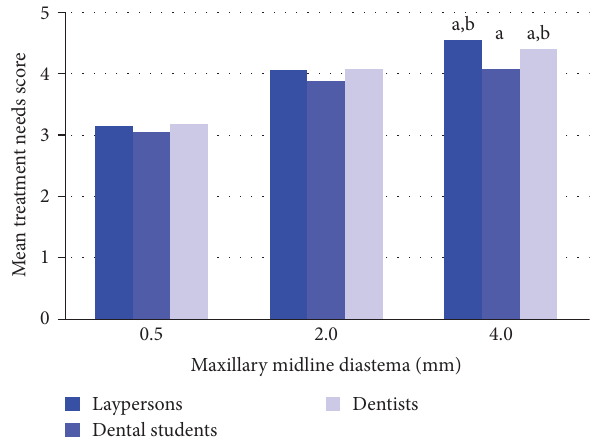
F IGURE 5: Treatment needs of maxillary midline diastema perceived by laypersons, dental students, and dentists. (a) Signi fi cant differ- ence of mean treatment needs score between groups, p < 0 : 05. (b) No signi fi cant difference of mean treatment needs score between groups, p > 0 :